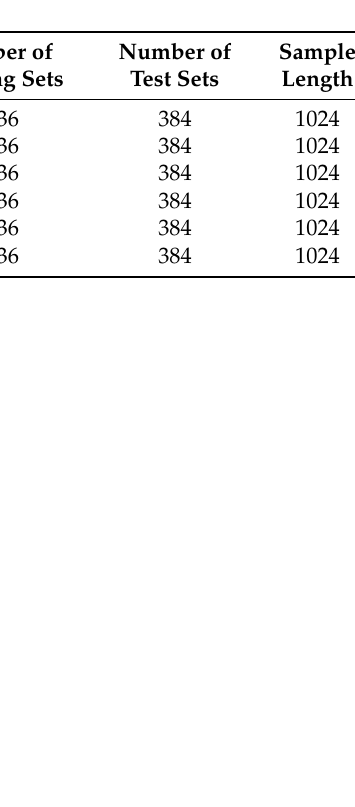
11 of 18 Figure 9. Bearing pictures of typical failure types. (a): Inner race wear (b): Outer race wear (c): Cage fracture (d): Outer race fracture In this paper, two of the three working conditions of the XJTU-SY dataset are taken as experimental data, totaling six categories. Aiming at the problem that the total length of the vibration signal varies among different fault types, the above-mentioned overlap- ping sampling method is used to process the original data. The specific experimental sam- ples are shown in Table 4. In each fault type, the number of fault samples is 1920, and 1536